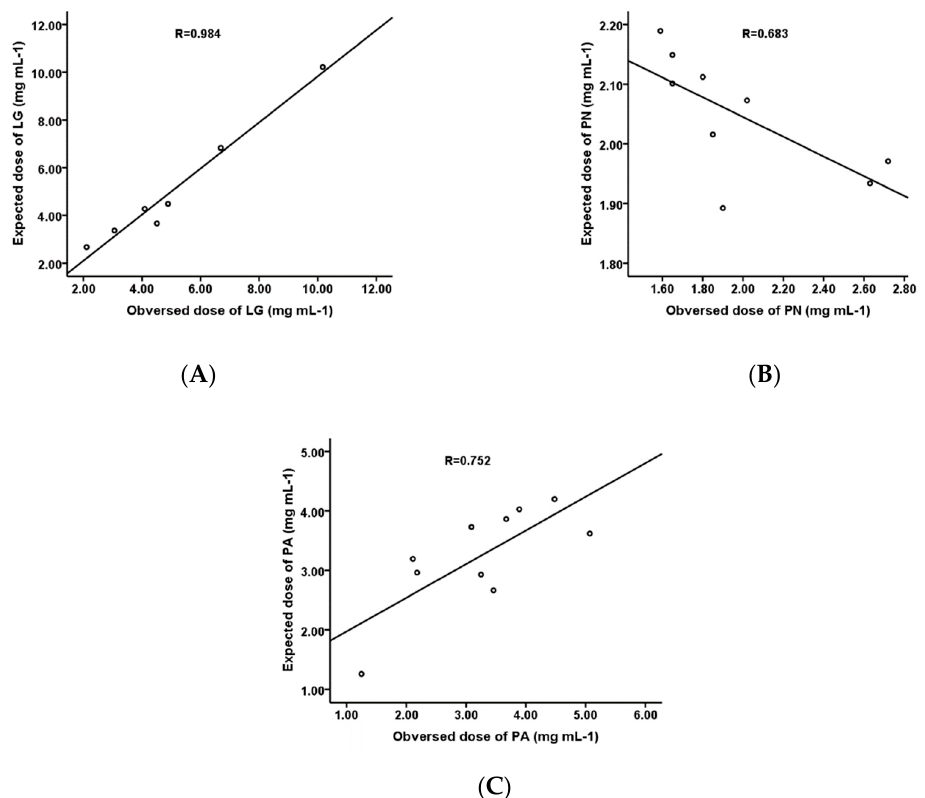
Figure 4. The correlation between observed and expected antioxidant IC 50 values on LG ( A ), PN ( B ), and PA ( C ). Antioxidant activities were expressed as a dose required for half the DPPH free radical. Table 6. The antioxidant IC 50 values of compounds and the correlations between contents and IC 50 values of extracts.